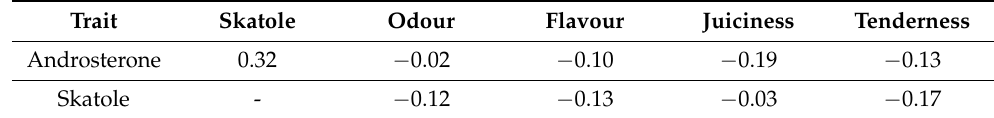
Table 4. Pearson’s correlation coefficients between traits.